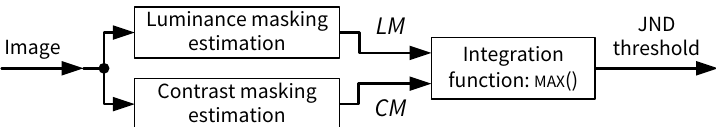
Figure 1. Chou and Li’s pixel-domain just-noticeable difference (JND) model